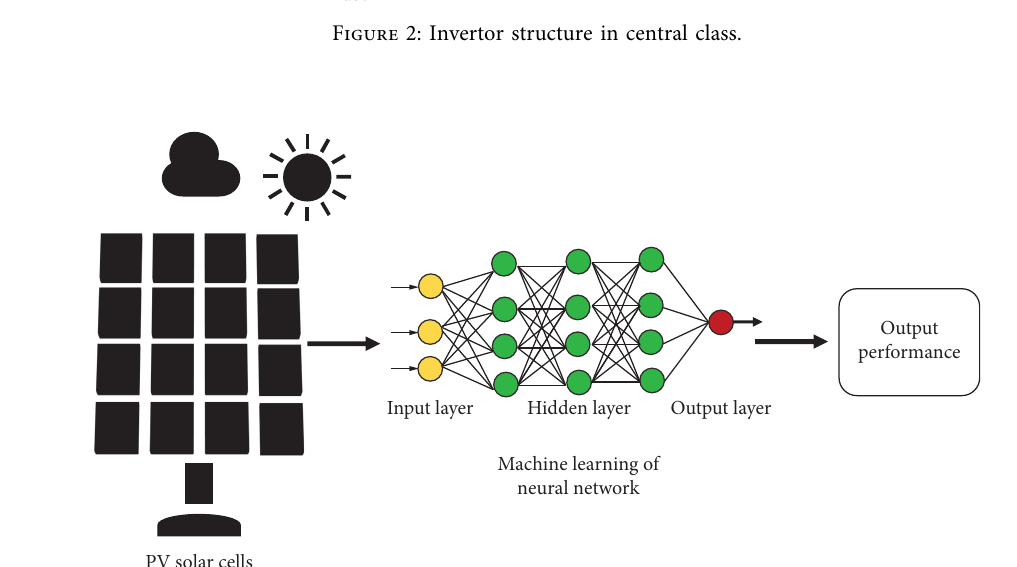
Figure 3: Deep learning system of PV solar cells.